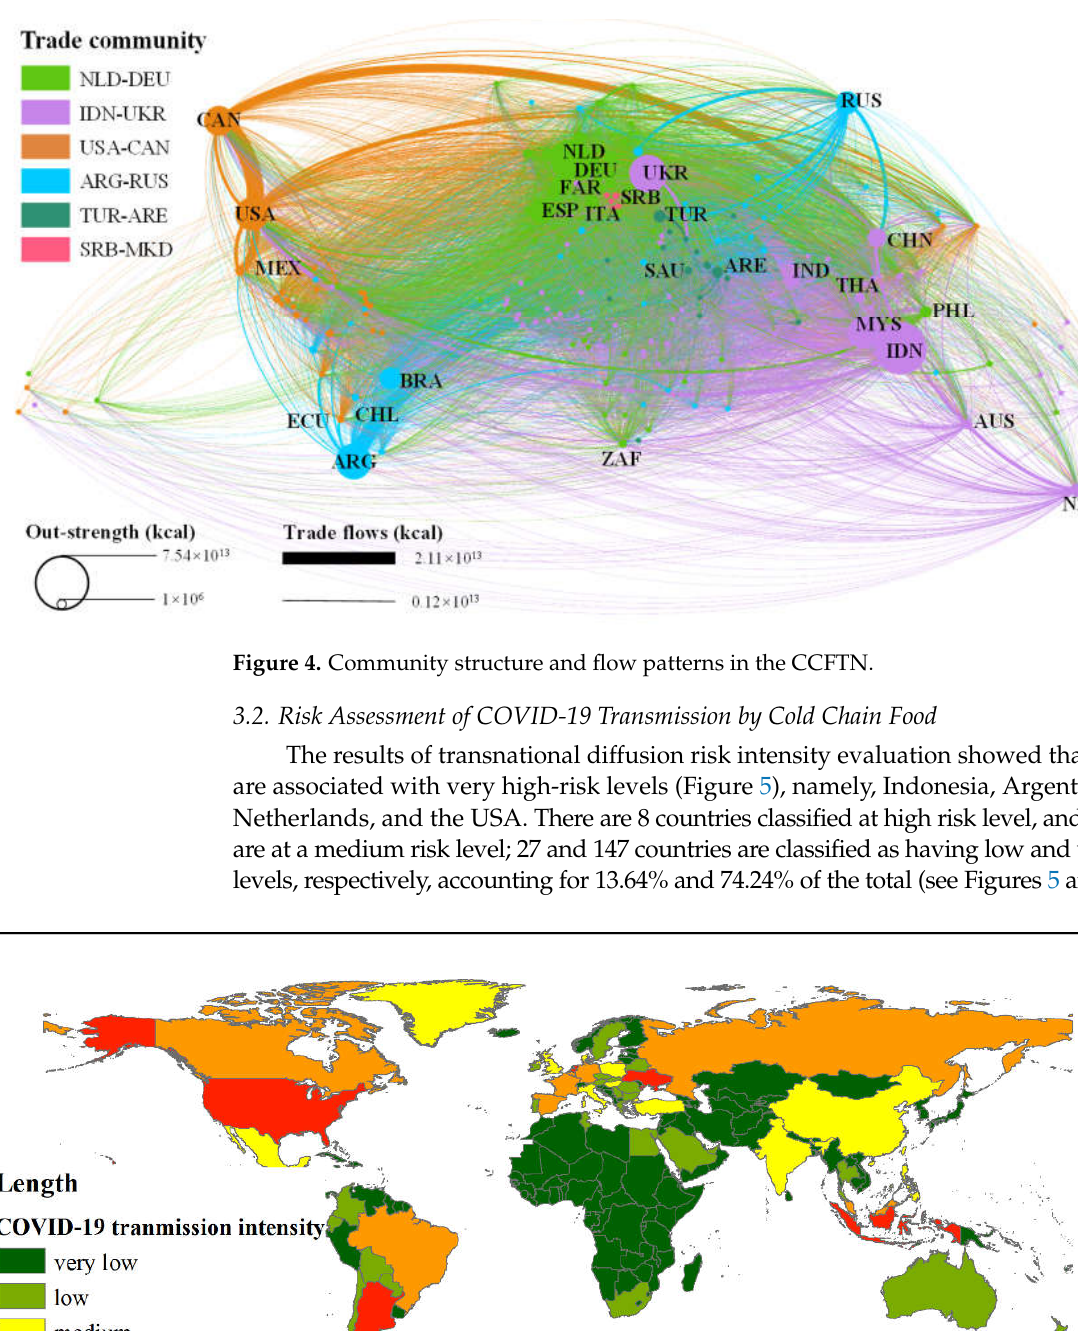
Table 4. Characteristics of the CCFTN community structure.